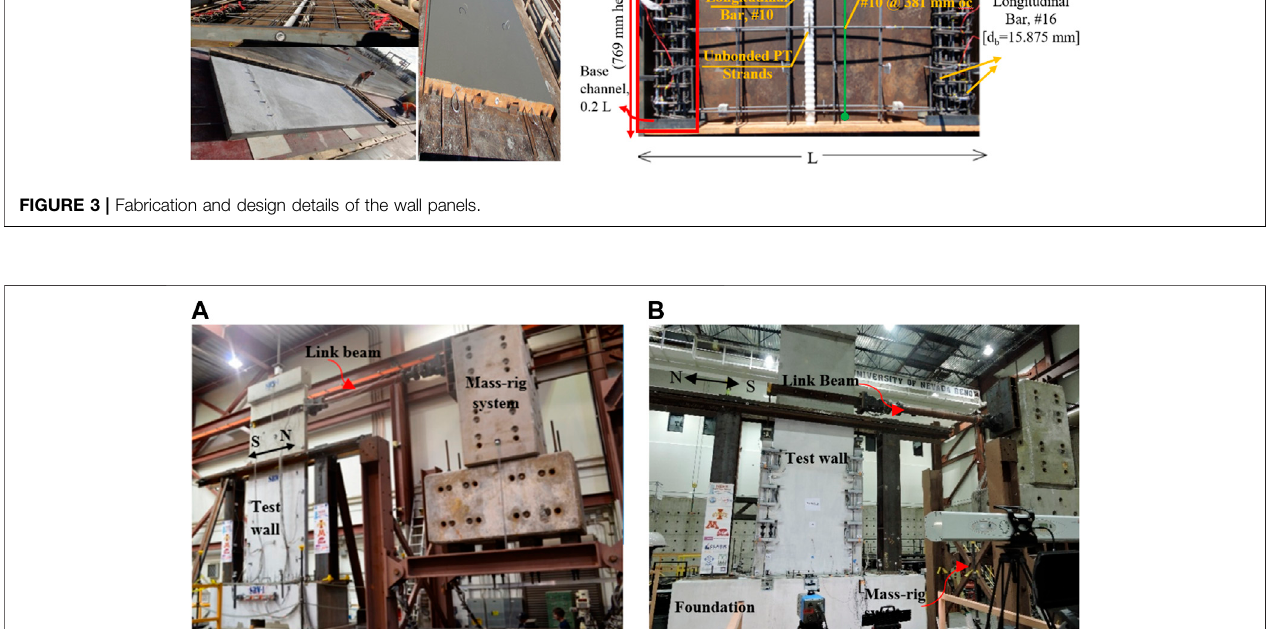
FIGURE 4 | Shake table test setups at UNR: (A) SRW; (B) PreWEC (Nazari and Sritharan, 2020).